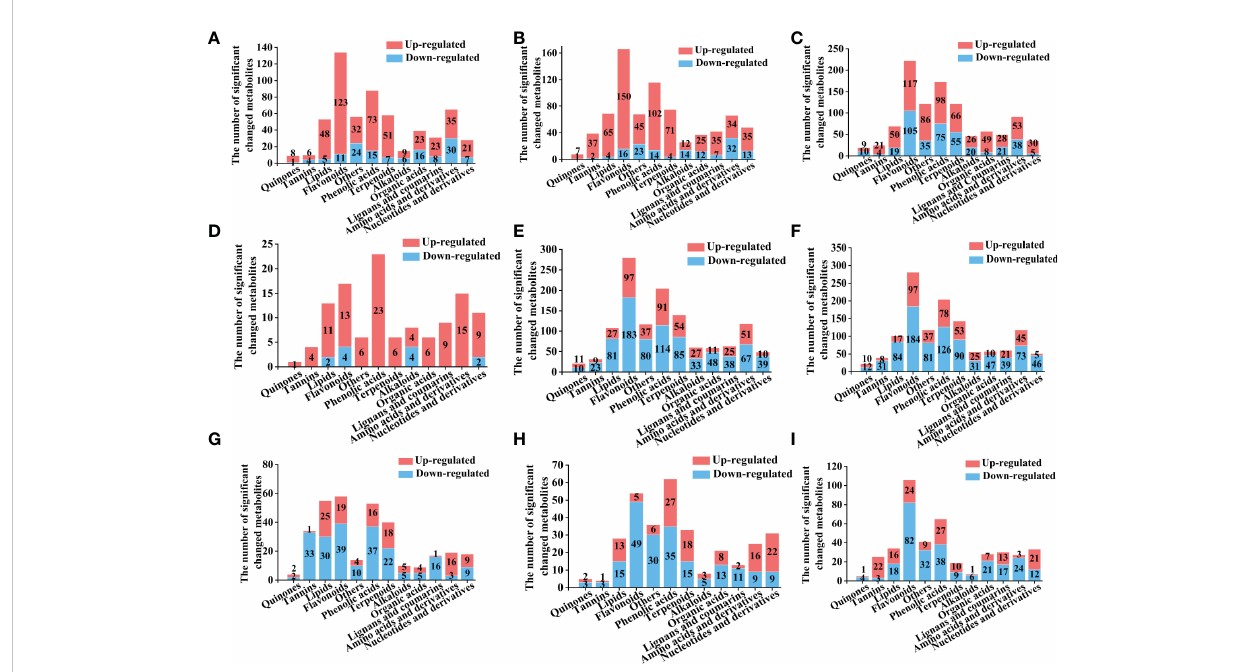
FIGURE 5 Number of di ff erent types of di ff erential metabolites for the comparison group, Y-R vs Q-R, Y-RP vs Q-RP, Y-RS vs Q-RS, Q-R vs Q-RP, Q-R vs Q-RS, Q-RP vs Q-RS, Y-R vs Y-RP, Y-R vs Y-RS, and Y-RP vs Y-RS (A-I). Yellow column indicates metabolites that were signi fi cantly up-regulated, blue column indicates metabolites that were signi fi cantly down-regulated. Signi fi cantly regulated metabolites between groups were determined by VIP ≥ 1 and FC ≥ 2 or ≤